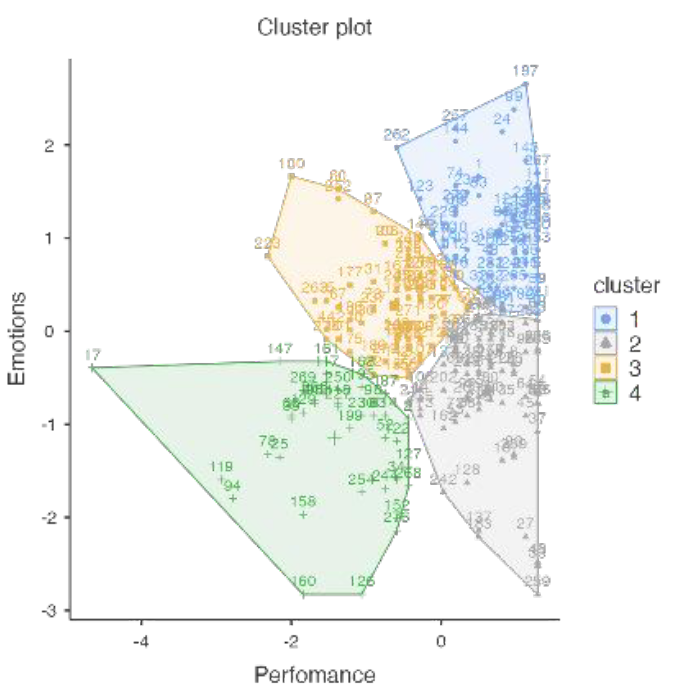
Figure 9. Plot of means across clusters between Emotions and Job Performance. Cluster 1: happy- productive; Cluster 2: unhappy-productive; Cluster 3: happy-unproductive; Cluster 4: unhappy- unproductive. (Study 2; N = 281) (r = 0.26; p < 0.001).